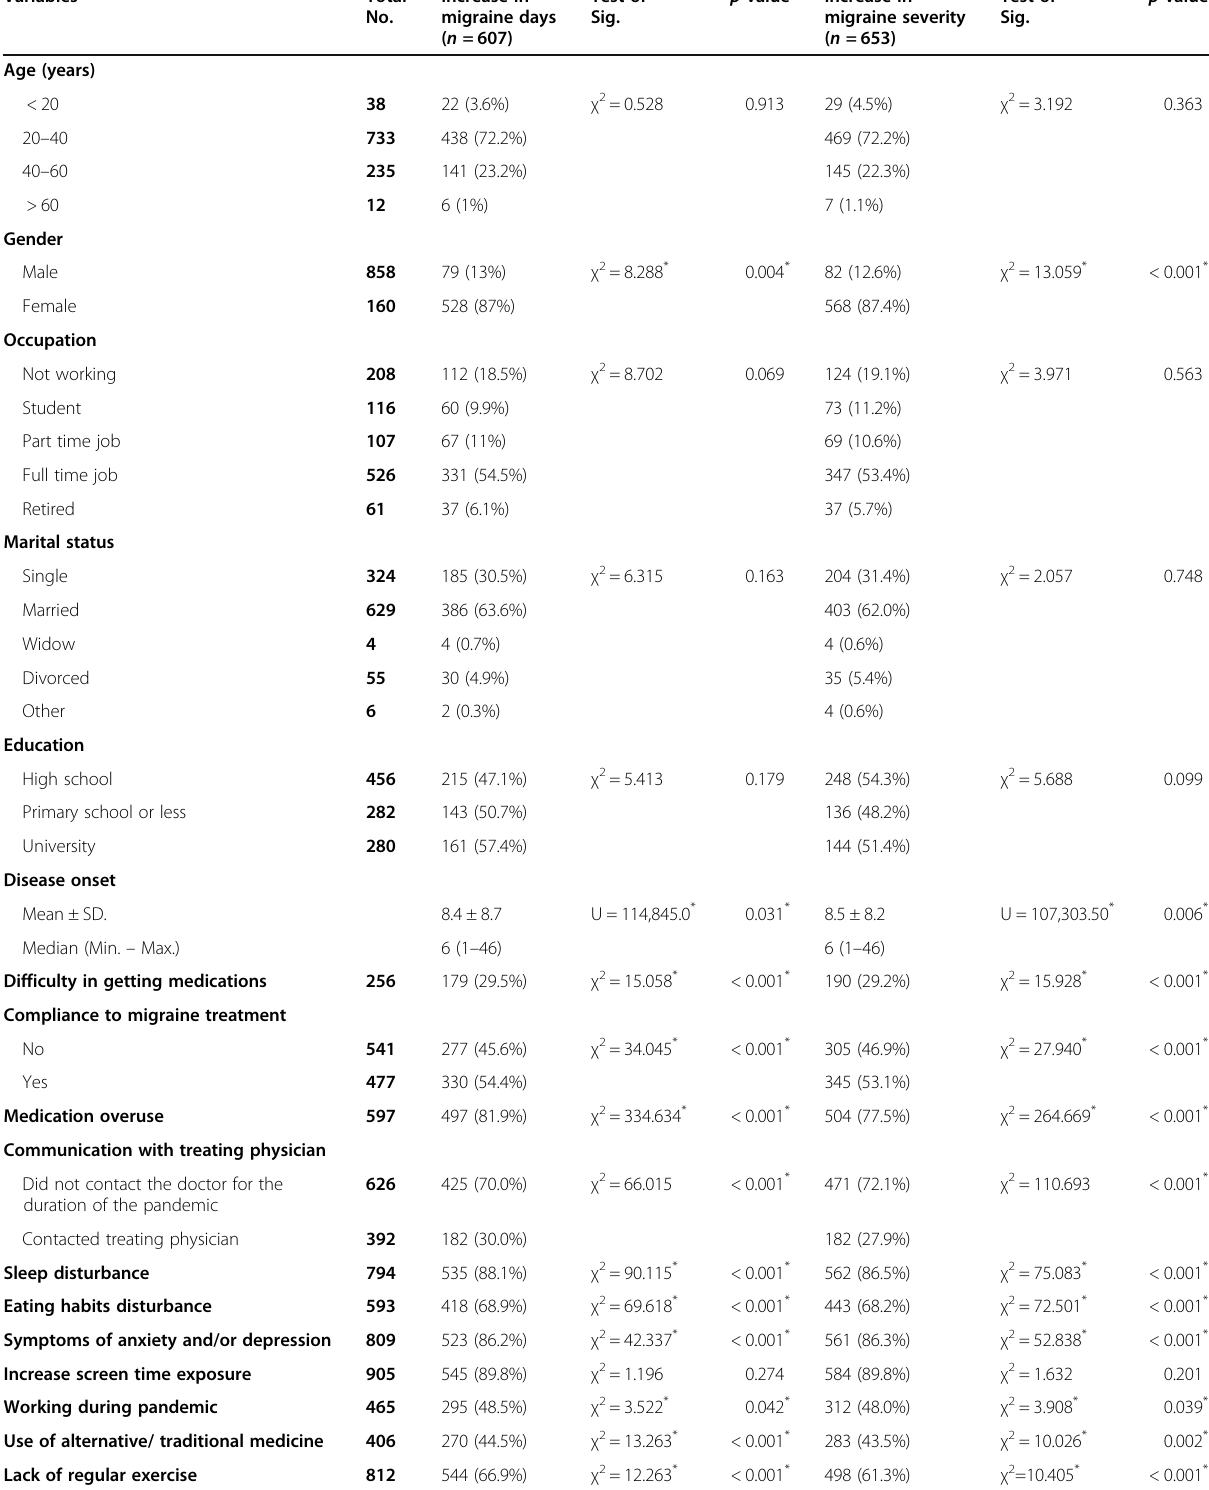
Table 2 Relation between increase in migraine frequency and increase in migraine severity with different variables (n = 1018) Variables Total